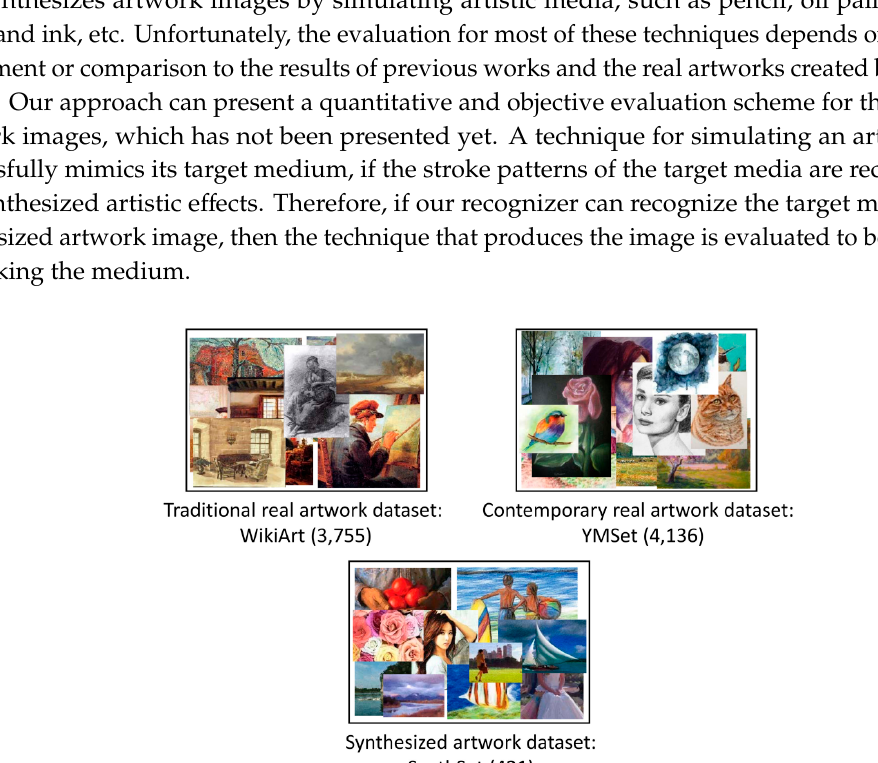
Figure 4. The process of our approach. 2. Related Work Many machine learning researchers classify artworks and photographs according to their styles. Some of them try to classify artworks according to the material, such as paper, wood, silver, oil, ink and watercolor, etc. In the early days, handcrafted features were widely used. Recently, the convolutional neural network (CNN)-based approaches are spotlighted. 2.1. Schemes Using Bandcrafted Features Keren et al. [2] classified artworks according to their creators by the style of the artwork. Their scheme employed DCT coefficients as their classifying features. As a result, they classify five painters from 30 artworks. Li et al. [3] classified artists of Chinese ink paintings by analyzing wavelets from the brush strokes drawn on the artworks and Lyu et al. [4] applied Li et al’s scheme to classify 13 drawings. Johnson et al. [5] presented a scheme that classifies van Gogh’s paintings. However, these schemes show poor performance. They do not classify sufficient number of artworks and artists. Shamir et al. [6] presented a style of an artwork as its creator, and the school of the creator. They defined 11 features using histogram analysis and edge statistics and classified three schools and nine creators from 60 artworks. Liu et al. [7] classified DART dataset that has 1.5 K paintings by employing handcrafted features, such as color, composition, line and their combinations. They compared the performances of several decision schemes, including SVM. They classify artworks into six schools of arts, including baroque, cubism, and impressionism. They also classify their creators. The handcrafted feature-based schemes have difficulties in defining implicitly expressed styles with a set of explicit features. Most of them classify limited artwork classes and test their schemes on only easily distinguishable artworks. Mensink et al. [8] presented an automatic classification technique on the photographs taken on the collections in Rijksmuseum in the Netherlands. They recognize a creator, a type, material and the creation year from the artworks. They recognize 20 material categories, such as paper, wood, silver, oil, ink and watercolor, etc. Their features are SIFT, which is effective in classifying different patterns.